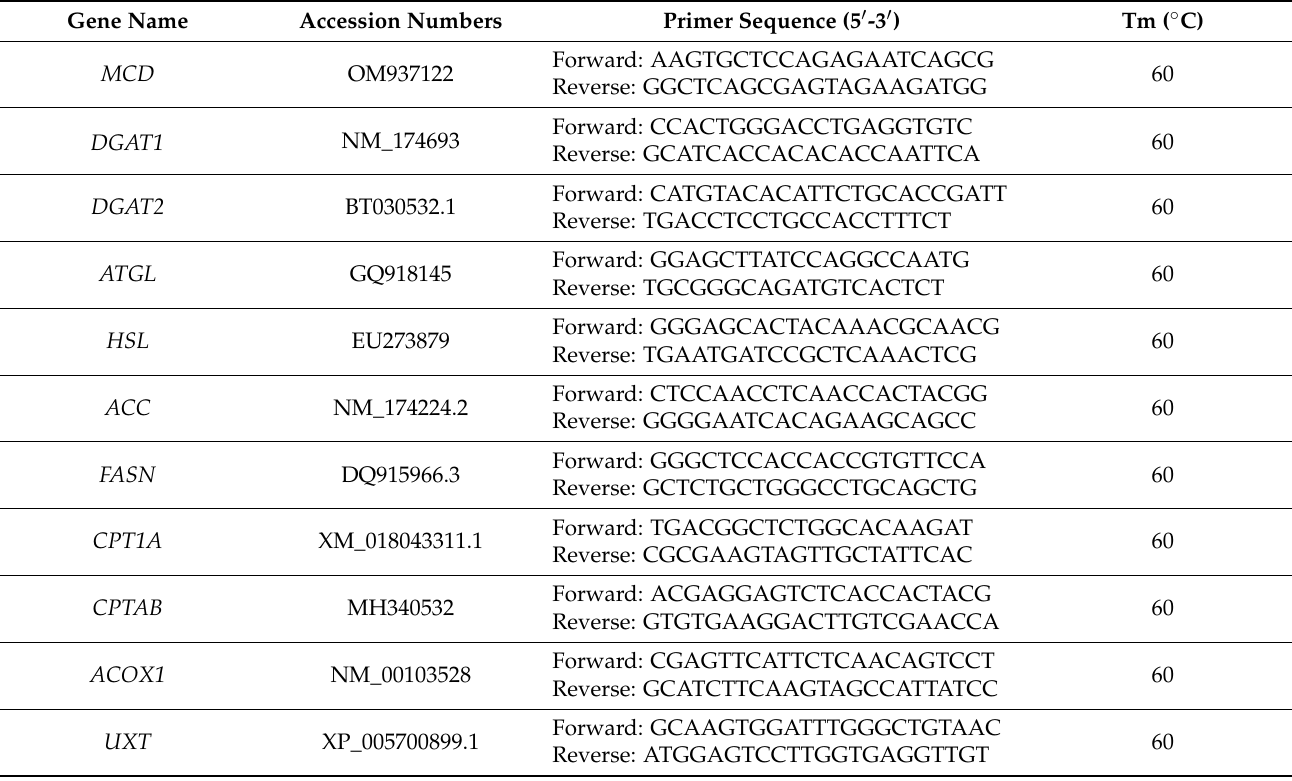
Table 1. Primer information for